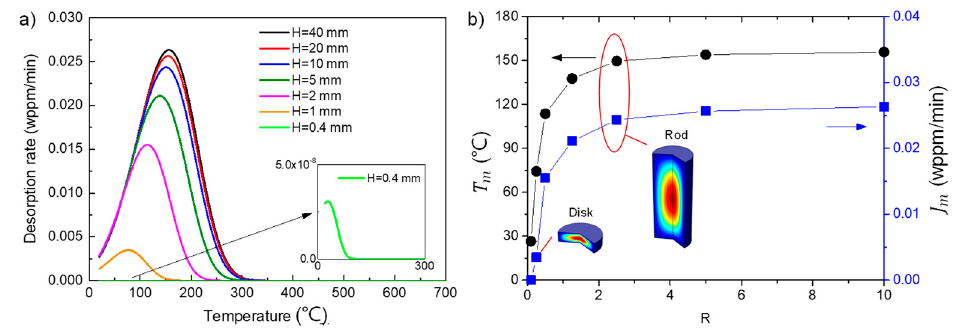
Figure 3. ( a ) Effect of the ratio of specimen height/diameter ( R = H / D ) on desorption spectra with the diameter fixed at 4 mm and height decreased from 40 to 0.4 mm and ( b ) the variation of peak temperature T m and peak flux J m with R . The parameters used in the simulation were identical with those in Figure 2, except that the heating rate was fixed at 200 K/h. Note that the rest time was t r = 3